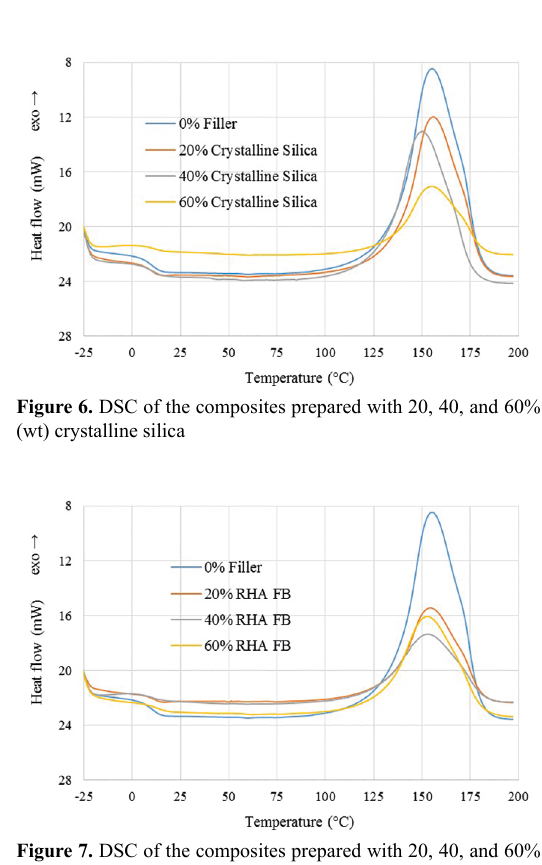
linear reaction between the epoxy ring and the catalyzer. The second is the reaction between the phenolic OH group and the catalyzer 19 . Therefore, the 'shoulder' observed in some DSC curves is due to these starter mechanisms, since the catalyst used reacts with the epoxy and the phenolic rings alike. A step is observed near 10 ºC (Figures 6 and 7), which represents chain mobility 27 . Tg is an important parameter considering material storage. Taking into account